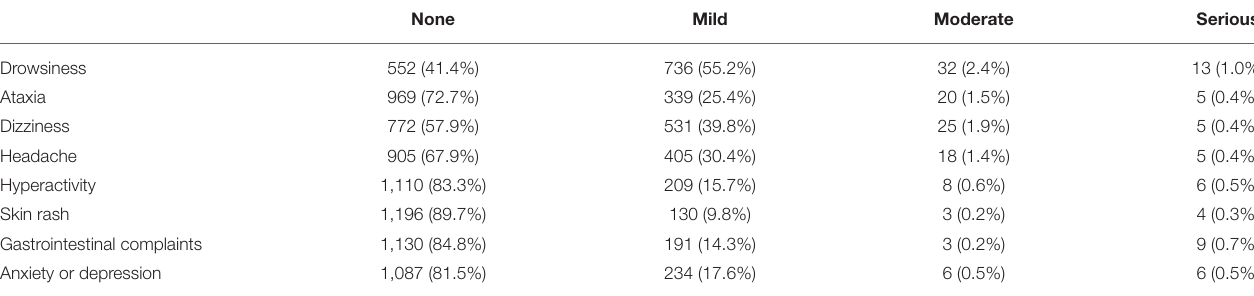
TABLE 5 | Adverse events, N (%).